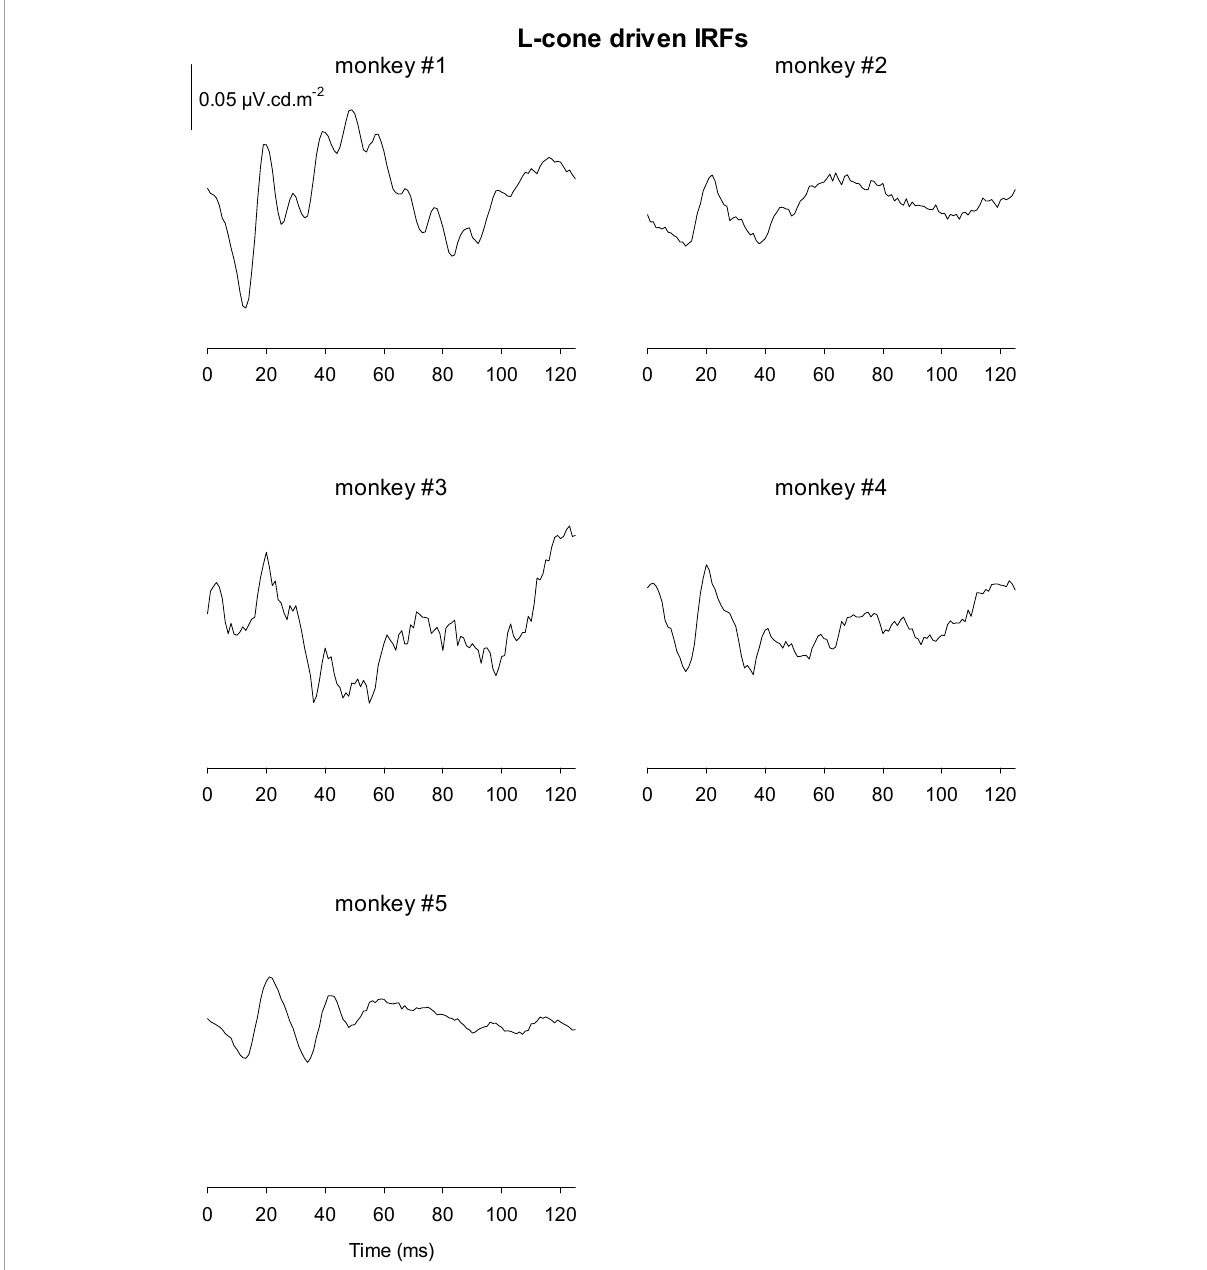
FIGURE9 IRFs derived from L-cone driven wnERGs for five